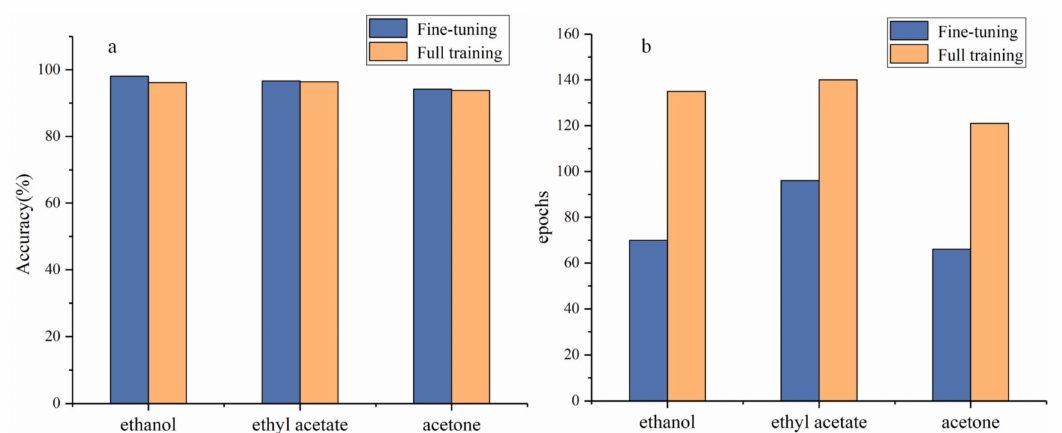
Figure 5. Results produced by fine-tuned and fully trained models. ( a ) Performance on the model validation set and ( b ) the number of epochs required for model convergence.